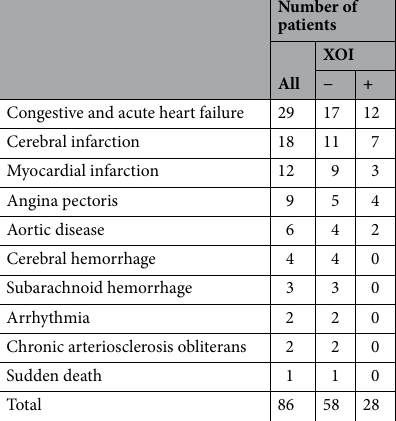
Table 2. Details of cardiovascular events. XOI xanthine oxidase